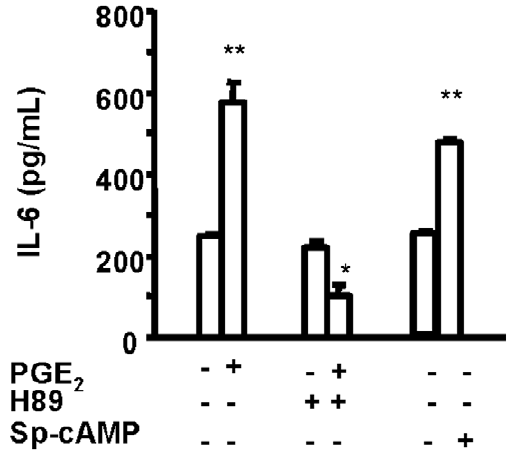
Figure 3. PGE 2 -induced IL-6 production can be attenuated by inhibitors of PKA. Confluent orbital fibroblasts, in this case from a patient with TAO, were treated with PGE 2 (1 m M) or Sp-cAMP (1 mM) in the absence or presence of H89 (10 m M). Media were collected and analyzed for IL-6 content after 16 hr incubations. Data are presented as the mean 6 SD of triplicate independent determinations from a single orbital fibroblast strain. . This result was confirmed in two other orbital fibroblast strains where IL-6 production was reduced 5.6 fold by H89. * denotes P , 0.005 compared to PGE 2 treatment alone; ** denotes P , 0.005 compared to no treatment.